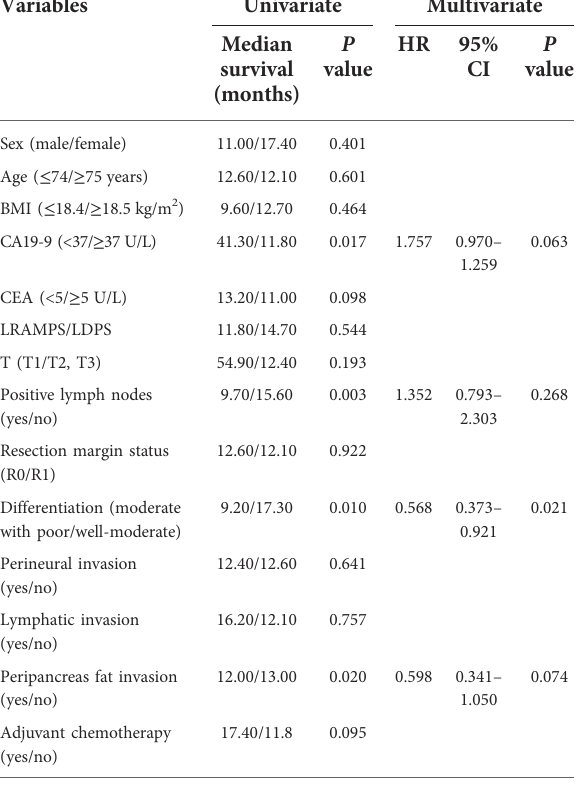
TABLE 2 Kaplan – Meier and Cox proportional hazard regression analysis of disease-free survival. Variables